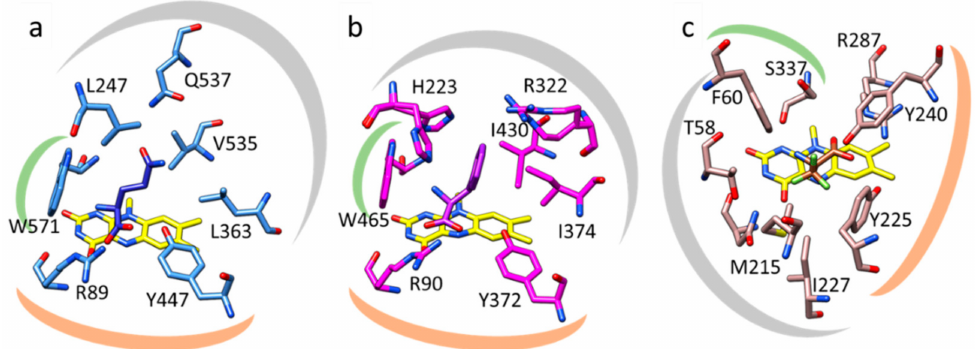
Figure 3. Structural comparison of active sites of amino acid oxidases. Active sites of ( a ) ancestral LAAO (7C4L), ( b ) LAAO from the Malayan pit viper (2IID), and ( c ) yeast DAAO (1C0L). In ( a ), residues R89 and Y447, highlighted by the orange mark, interact with the carboxyl group of the bound L-glutamine substrate (dark blue). In ( b ), the same role is exerted by R90 and Y372 for binding L-phenylalanine (purple). In ( c ), R287 and Y240 interact with the carboxyl moiety of the bound D-trifluoroalanine (dark brown). The green marks highlight the W571 and W465 in ( a , b ) respectively, which form part of the substrate binding pocket, close to the amine moiety of the bound substrate. In DAAO ( c ), a phenylalanine (F60) serves a similar role. The grey marks indicate the residues involved in binding of the substrate side chain in the three different amino acid